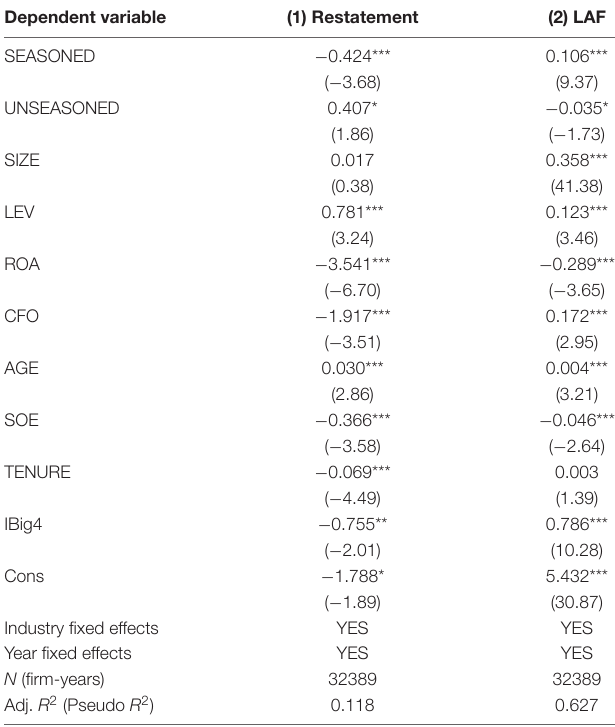
TABLE 5 | Entropy balance